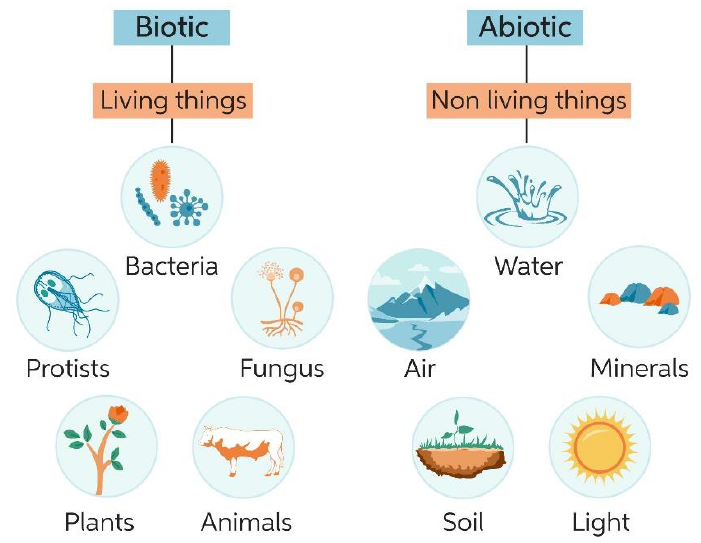
Figure 1. Biotic versus abiotic agents. Reproduced with permission from [21].